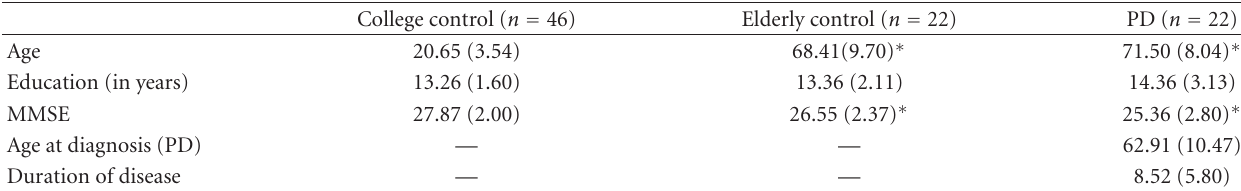
Table 1: Characteristics of participants (means and standard